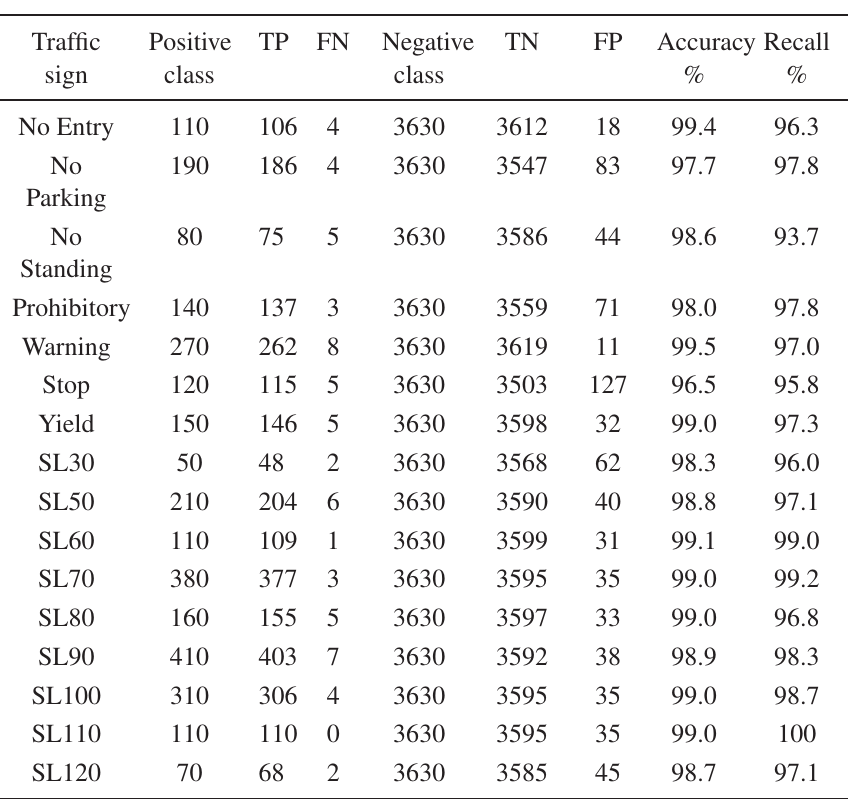
Table 2. Results of classification of different traffic sign